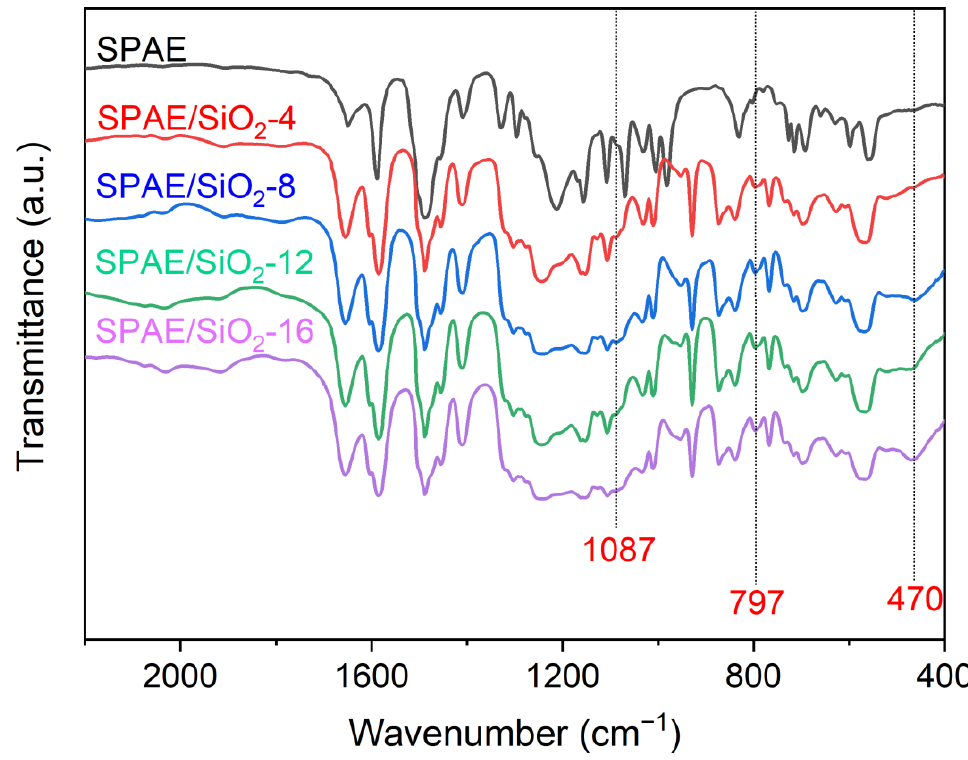
Figure 2. FT-IR spectra of the SPAE and SPAE/SiO 2 composite PEMs.